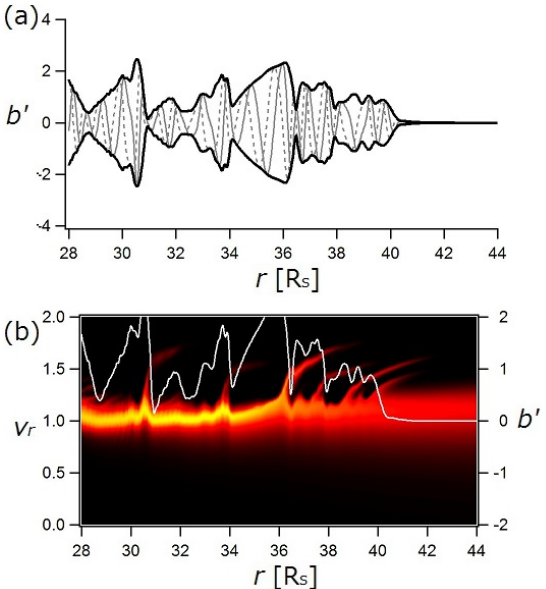
Fig. 4. The local VDFs ( g 0 at t = 22 . 0) at (a) r = 36 and (b) r = 41 in Run B.